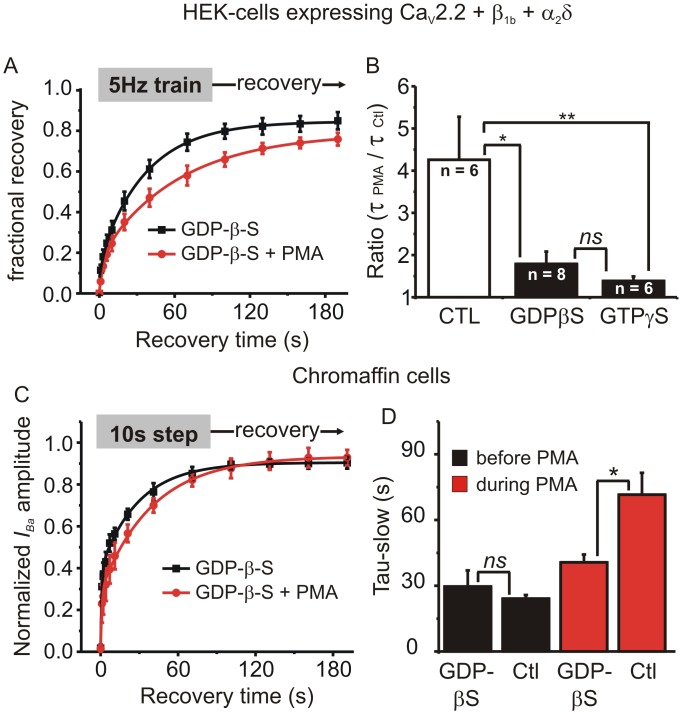
Intracellular application of GDP-β-S or GTP-γ-S reduced the effect of PMA on recovery from inactivation.
(A) HEK293 cells expressing CaV2.2, β1b and α2δ were recorded with patch pipette solution containing 0.5mM GDP-β-S and stimulated with a 5Hz/10s train. Fractional recovery from inactivation is plotted over time and the solid lines show a double exponential fit to the mean data (fit parameters: GDP-β-S A1 = 0.13, A2 = 0.71, t1 = 0.9 s, t2 = 35.0 s; GDP-β-S + PMA A1 = 0.18, A2 = 0.61, t1 = 3.6 s, t2 = 62.7 s, comparison of fits F = 12.9 p < 0.0001). (B) The change in recovery rate produced by PMA (tau in the presence of PMA / tau before application of PMA) for control cells, cells recorded with GDP-β-S in the patch pipette solution, and cells recorded with GTP-γ-S in the patch pipette solution (ns, not significant, * p < 0.05, ** p < 0.01; ANOVA with Bonferroni’s post-test for multiple pairwise comparisons). (C) Endogenous I
Ca was recorded from adrenal chromaffin cells with GDP-β-S in the patch pipette solution. Chromaffin cells were stimulated with a 10s step depolarization and recovery from inactivation was tracked at the indicated time points before and during application of PMA. The mean recovery data was fit with a double exponential (fit parameters: GDP-β-S Y0 = 0.02, A1 = 0.36, A2 = 0.52, t1 = 0.8 s, t2 = 28.1 s; GDP-β-S + PMA Y0 = 0.02, A1 = 0.25, A2 = 0.66, t1 = 0.8 s, t2 = 37.4 s, comparison of fits F = 1.65 p = 0.2). (D) Mean (± sem) data are shown for the slower of the two time constants from control cells (Ctl, n = 7) and cells recorded with GDP-β-S (n = 4). GDP-β-S had no effect on recovery rate in the absence of PMA (black bars) but significantly reduced the slowing of recovery produced by PMA (red bars) (ns, not significant, * p < 0.05; ANOVA with Bonferroni’s post-test for multiple pairwise comparisons).